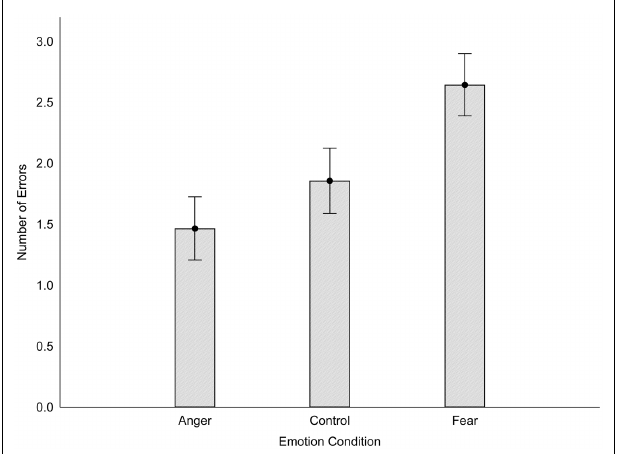
FIGURE 2 | Performance on the two-point discrimination task as a function of emotion condition (Study 1). Higher scores indicate poorer tactile sensitivity. Error bars reflect standard